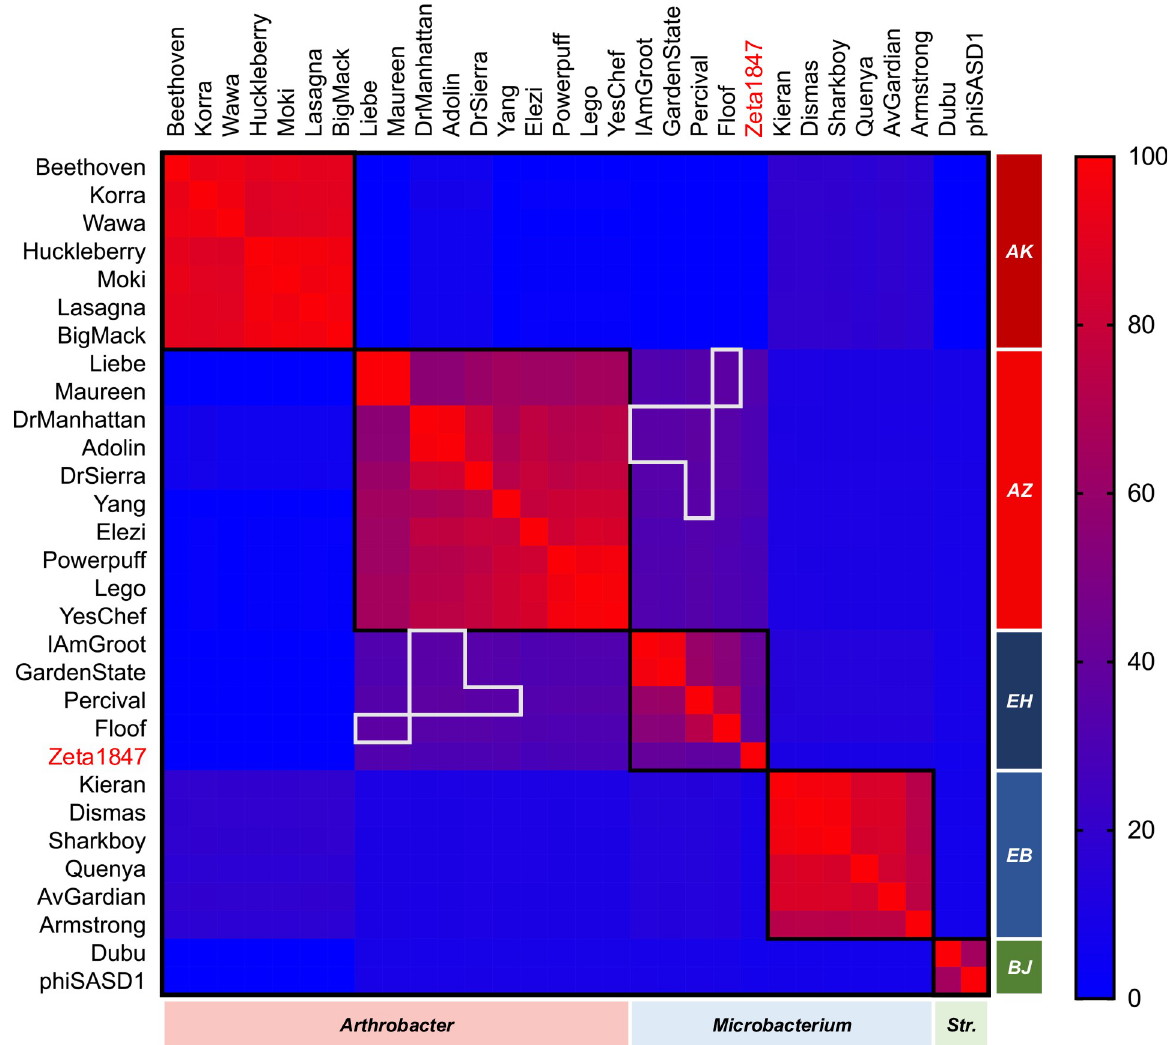
Fig 5. Cluster AZ and EH phages share gene content in excess of Microbacterium clustering parameters. GCS values were recorded using the PhagesDB Explore Gene Content tool and visualized as a heat map using Prism 8.0.0. Cells boxed in white represent pairwise GCS values in excess of gene content clustering parameters ( � 35%) between phages belonging to different clusters. Cells boxed in black represent phage clusters. The former singleton Zeta1847 is indicated in red. “ Str . ” indicates phages infecting Streptomyces . Some phages in Clusters AZ and EH shared over 35% GCS, in excess of the Microbacterium clustering parameter. The former singleton Zeta1847 shared over 35% GCS with Cluster EH phages, which resulted in the clustering of this phage with Cluster